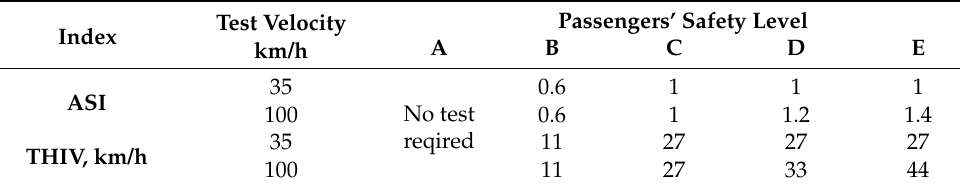
Table 1. Levels of the safety of the vehicle passengers for the velocity class 100 km · h − 1 according to EN 12767